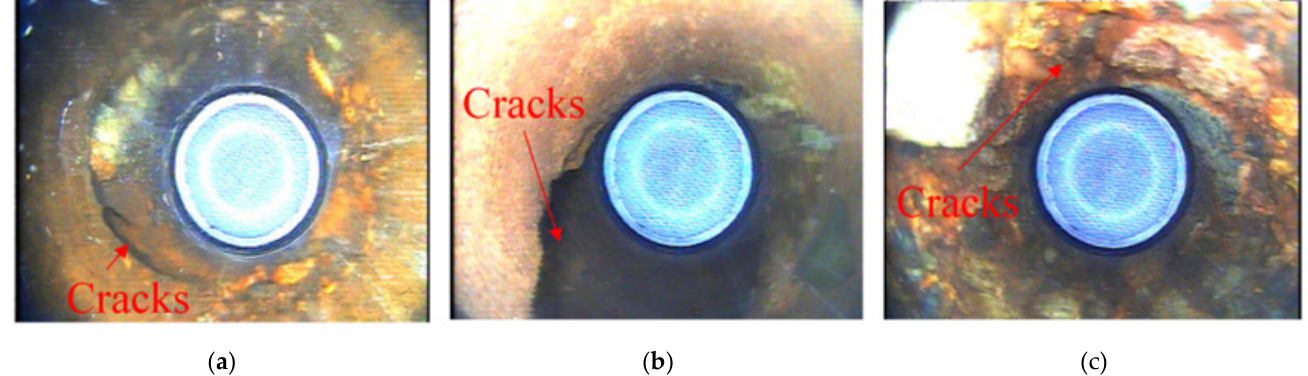
Figure 4. The results of D2 drilling TV images. ( a ) Depth: 119.60 m, ( b ) depth: 386.90 m, ( c ) depth: 392.59 m.